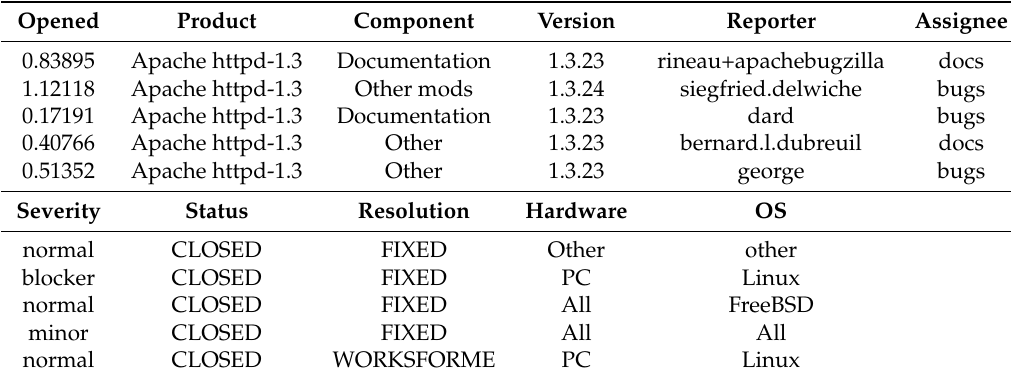
Table 1. A part of the raw fault big data.